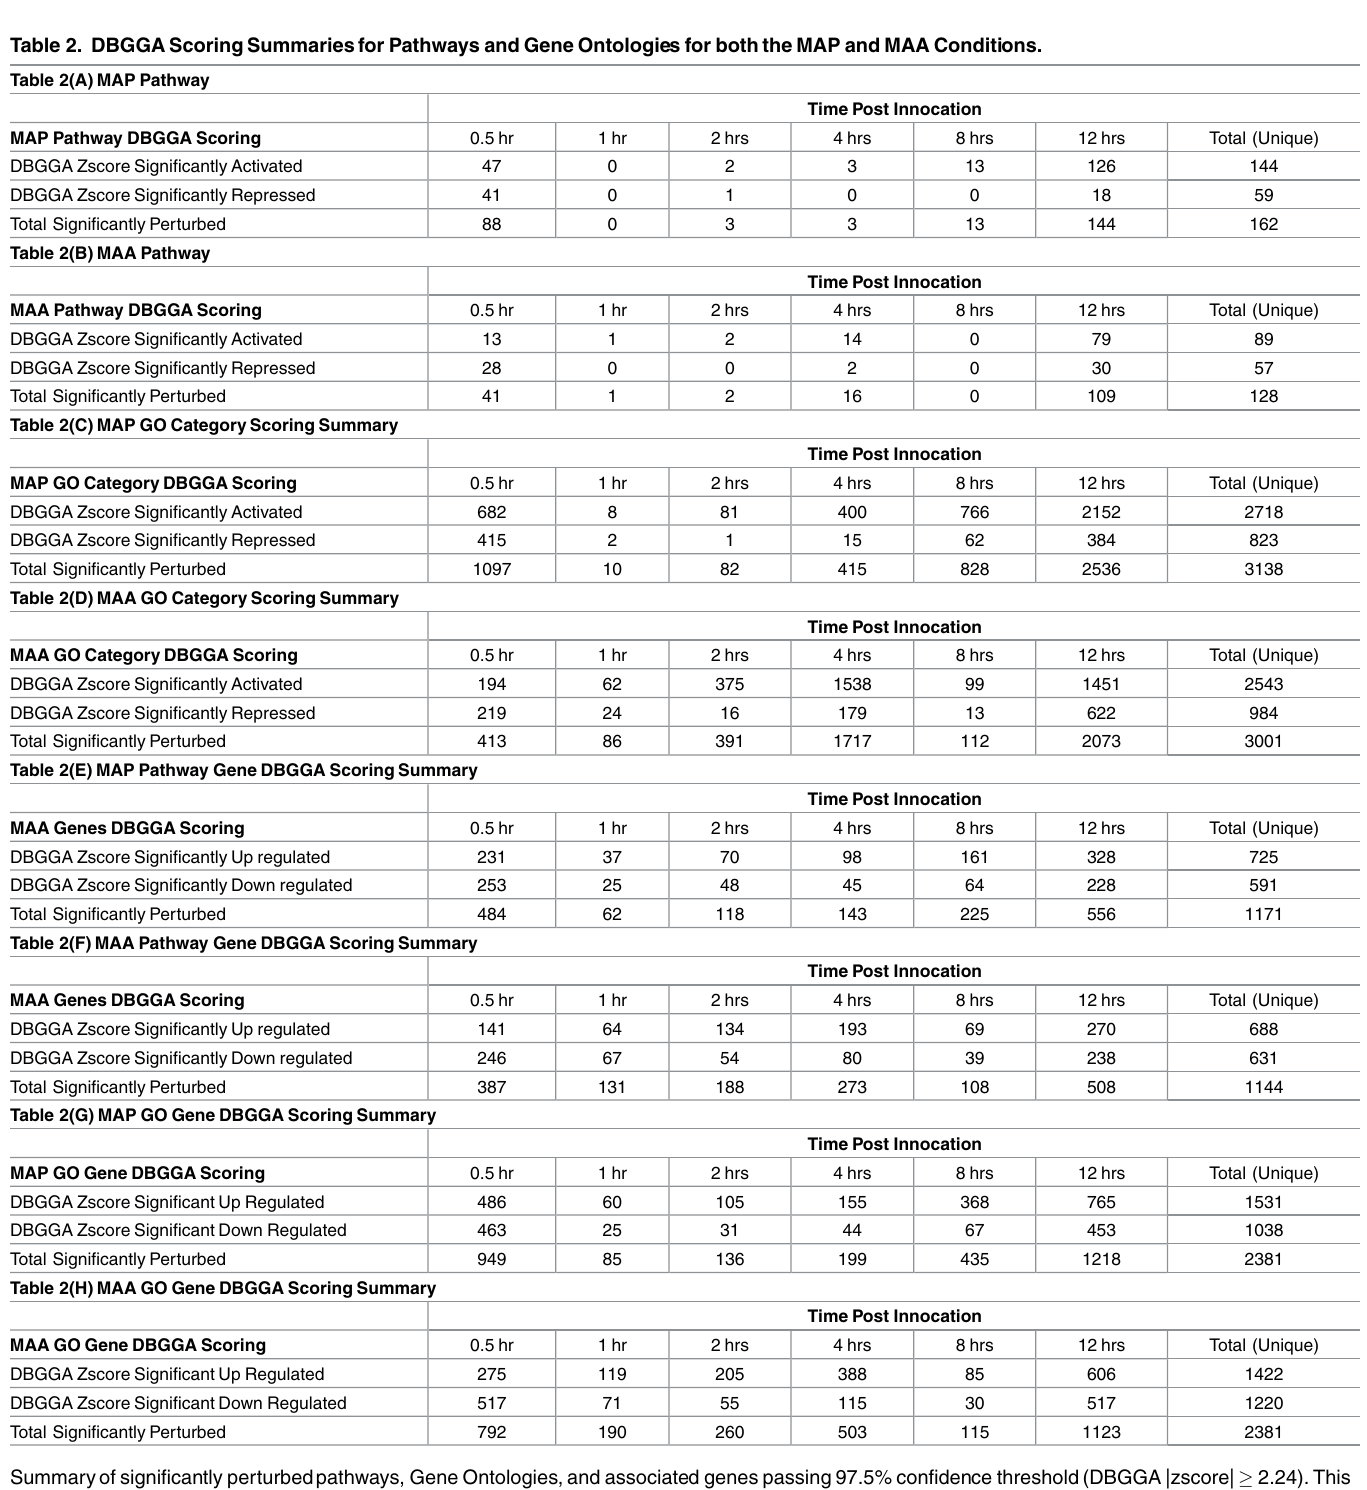
table compares:(A) MAP versus PBS (uninfected)pathway scores; (B) MAA versus PBS pathway scores; (C) MAP versus PBS Gene Ontologyscores; (D) MAA versus PBS Gene Ontologyscores; (E) MAP versus PBS Pathway gene scores; (F) MAA versus PBS Pathway gene scores; (G) MAP versus